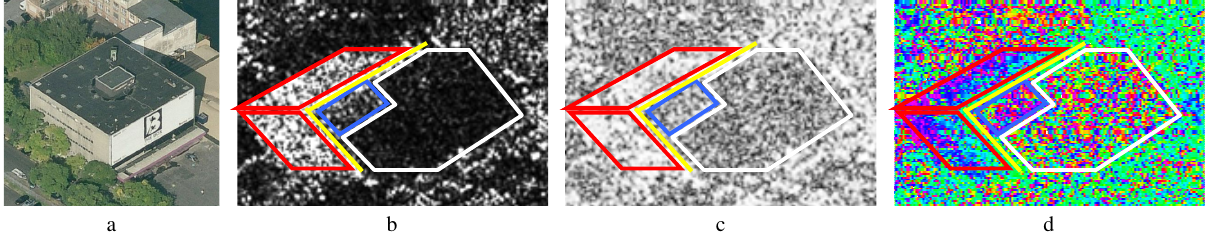
Figure 3: Building signature in optical data (a, source: Bing), intensity (b), coherence (c), and interferometic phase data (d), building layover (red), corner (yellow), roof area (blue), radar shadow